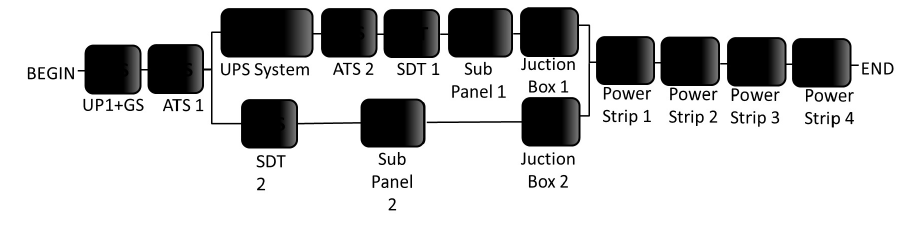
Figure 17. RBD model of Tier